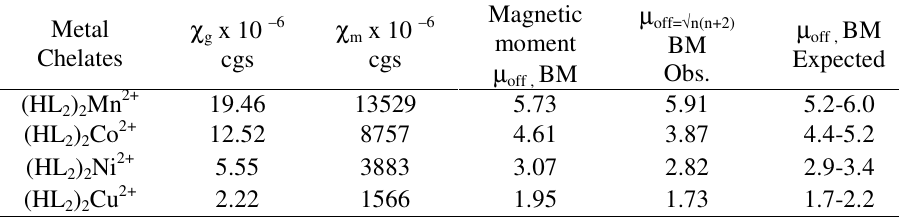
Table 2 . Experimental data of magnetic moment for metal chelates of HL